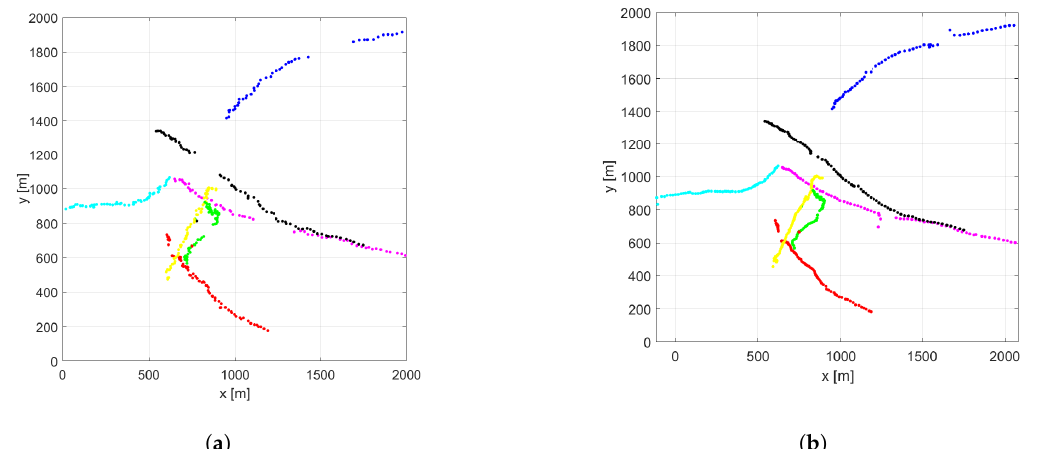
Figure 7. Estimated object positions in the example random trajectories scenario using the normal ( a ) and the proposed ( b ) PHD